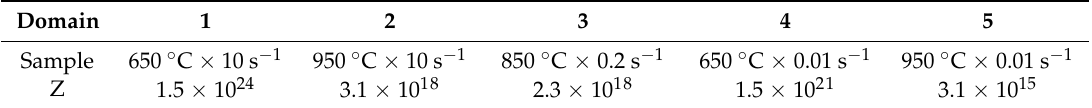
Table 7. Z values corresponding to the five domains.